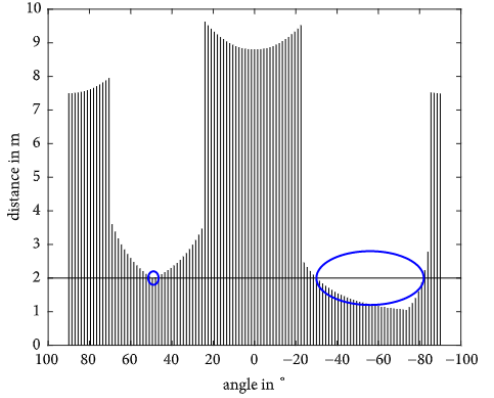
Figure 3. Sensor data and threshold distance.